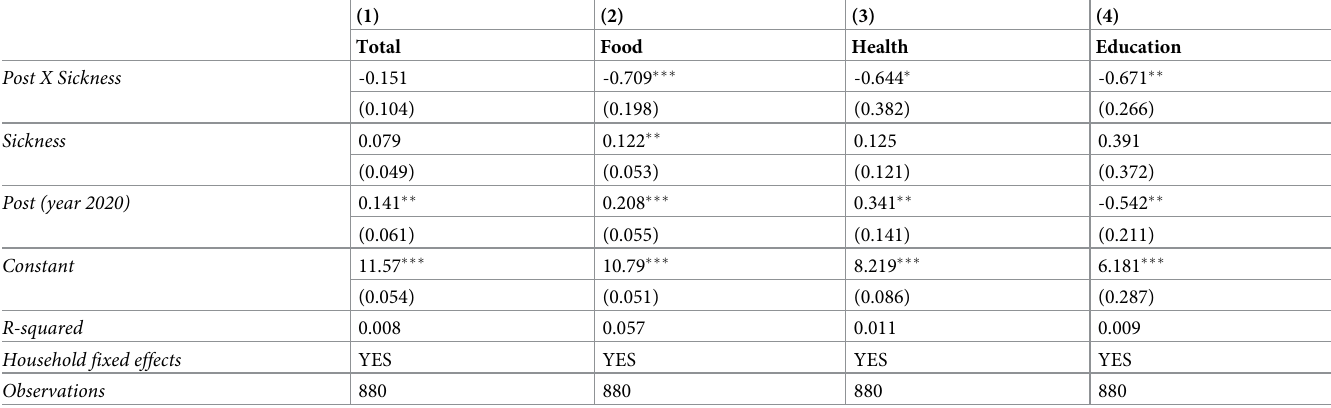
Table 7. Regression results for COVID-19 effects on household expenditure (in log)